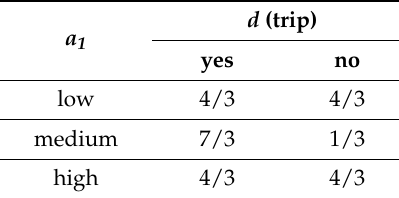
Table 11. Contingence table